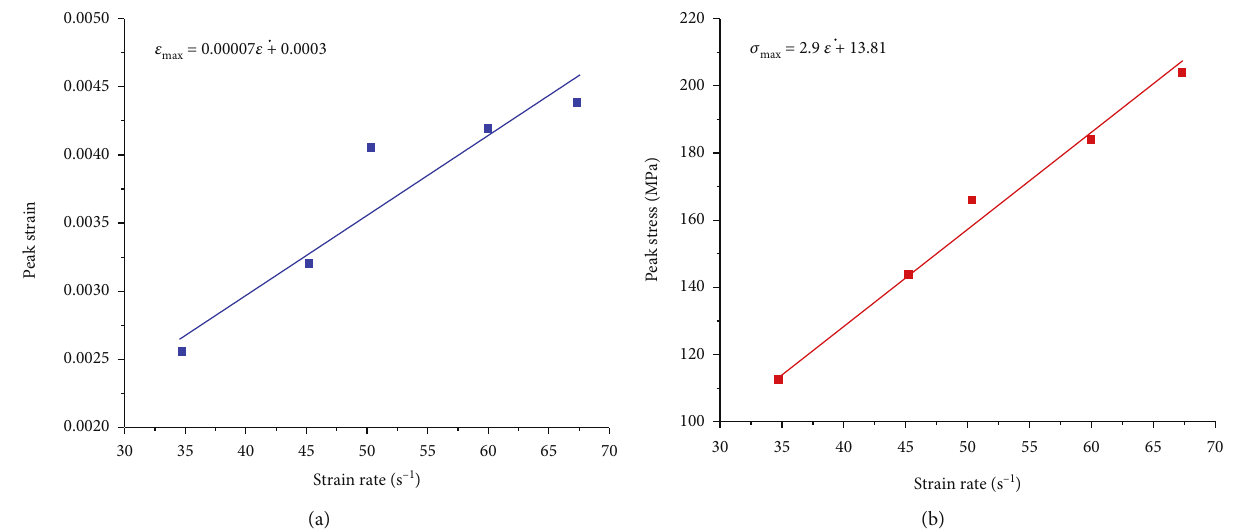
Figure 7: The relationship between peak strain and peak stress with strain rate. (a) Peak strain, (b) peak stress.